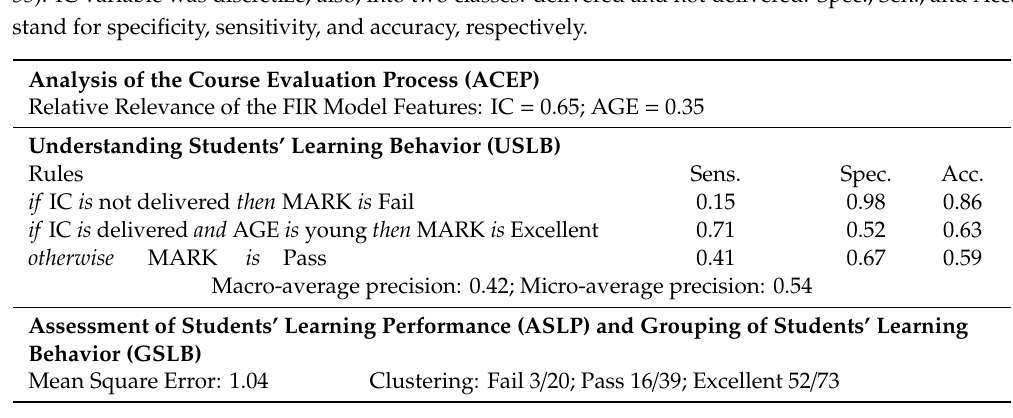
Table 3. ACEP, USLB, ASLP, and GSLB toolbox results for the model 2 of the didactic planning course. The MARK variable was discretized into three classes: fail (from 0–6), pass (from 6.1–8.9), and excellent (from 9–10). AGE variable was discretized into two classes: young (up to 35) and mature (more than 35). IC variable was discretize, also, into two classes: delivered and not delivered. Spec., Sen., and Acc. stand for specificity, sensitivity, and accuracy,